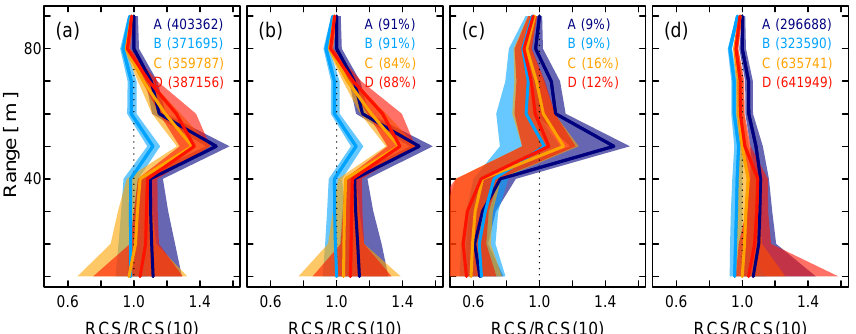
Figure 6. Median range-corrected signal reported RCS = P · r 2 of the lowest nine range gates (10–90m) normalised by the value at the 10th range gate for four LUMO sensors (Table 2) with firmware versions (a–c) 1.61 (A, B) or 2.01 (C, D) in 2013 and (d) 1.72 (A, B) or 2.03 (C, D) in 2015–2016, respectively. Statistics calculated for all profiles observed between 11:00 and 16:00UTC with RCS<200 × 10 − 8 a.u. in the lowest 400m: median (solid line) and interquartile rage (shading). Panels (b) and (c) separate the profiles from panel (a) into (b) profiles with the ratio at the third range gate, i.e. | RCS(3) / RCS(10) | exceeding or equal to 0.8, while (c) shows the profiles with the same ratio less than 0.8. For (a, d) the total number of 15s profiles selected is indicated by sensor ID (A, B, C, or D) and in (b, c) the percentages of the values from the total number of profiles in panel (a) are